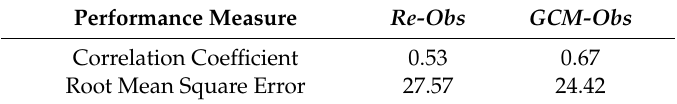
Table 2. Comparison of downscaled product with Observed using Re-Obs and GCM-Obs